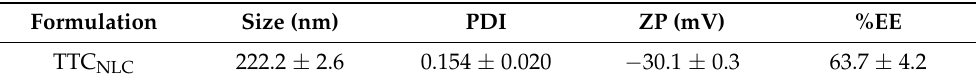
Table 1. Particle size, polydispersity index (PDI), zeta potential (ZP), and encapsulation efficiency (%EE) of TTC NLC . The values are shown as mean ± standard deviation.